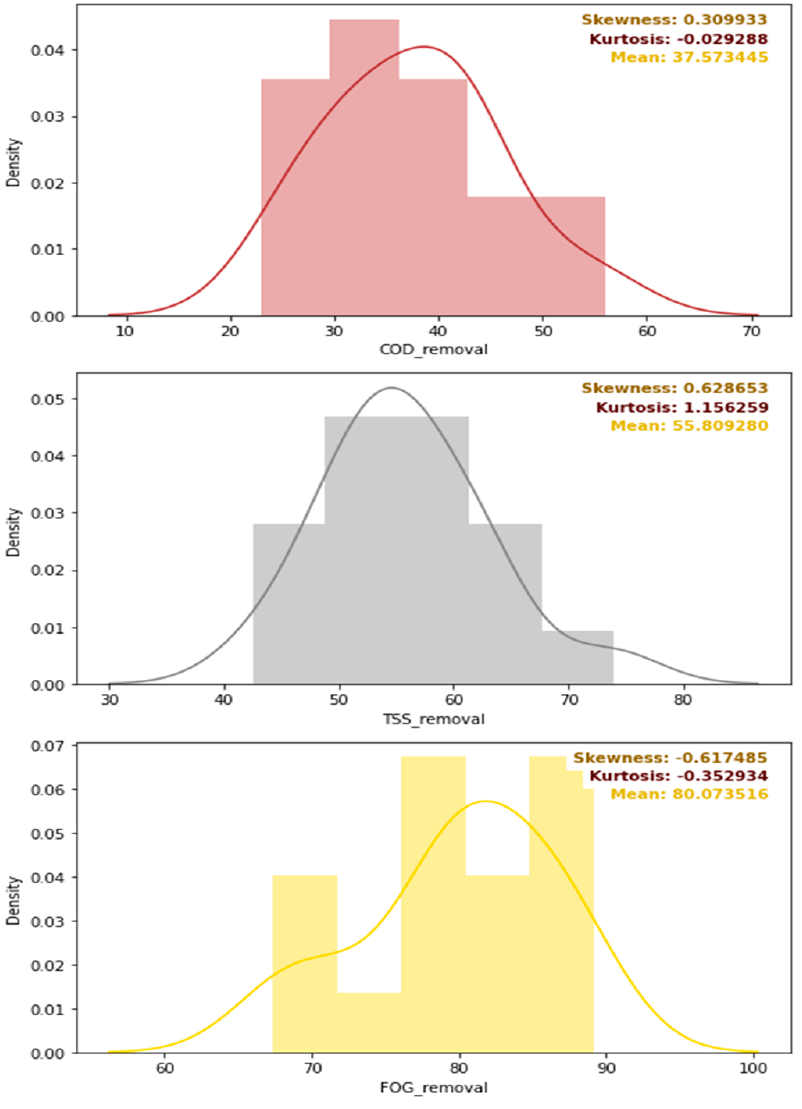
Figure 11. Density distribution, skewness, kurtosis, and mean values of the removal efficiencies of the pre-treatment stage.